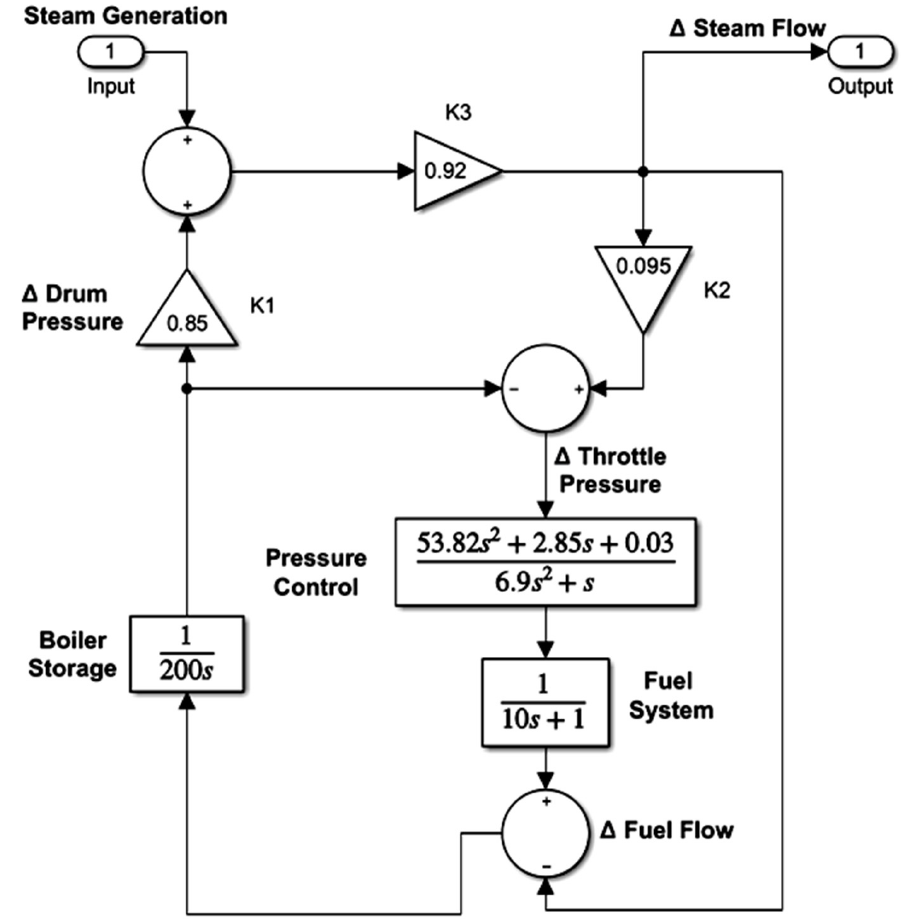
Figure 2. Transfer function model boiler dynamics[42].